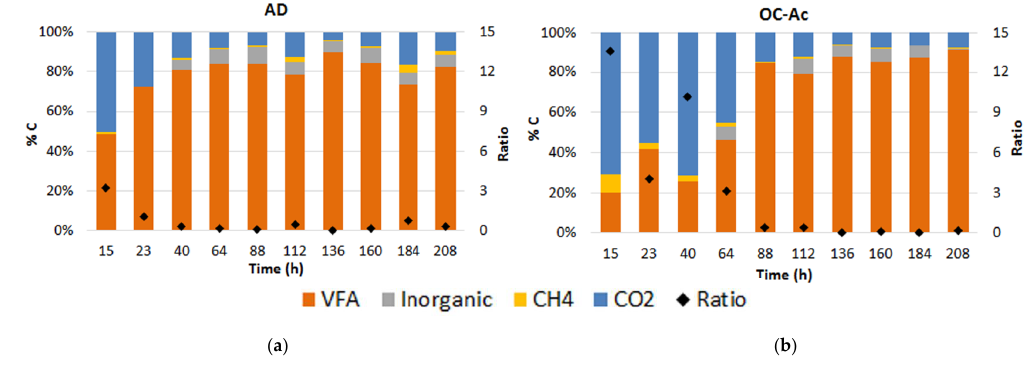
Figure 4. Comparison of performance of the ( a ) anaerobic digester and ( b ) the combined AD-BES system (OC-Ac): left-hand y-axis: proportion of degraded carbon compared to different compounds: VFAs, inorganic carbon, CH 4 , and CO 2 . Right-hand y-axis: ratio between the measured CO 2 values and theoretical CO 2 production on a stoichiometric basis, after VFA